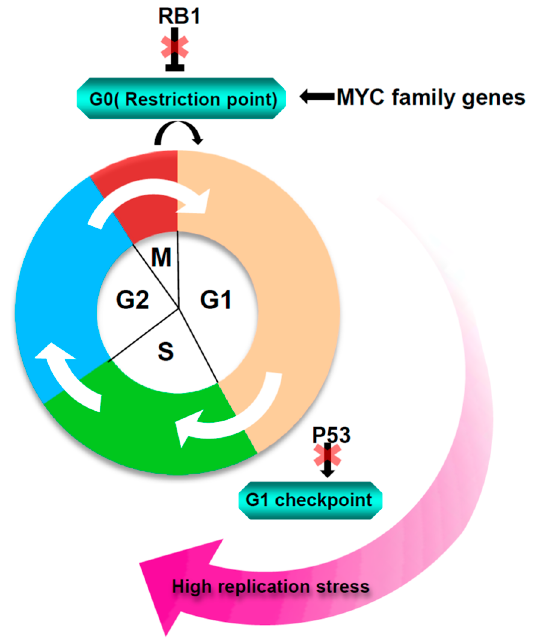
Figure 1. Causes of replication stress in small cell lung cancer (SCLC) cells. A number of endogenous obstacles that lead to replication stress in SCLC, including inactivation of tumor suppressors RB1 and p53, as well as amplification of MYC family genes. RB1 loss or amplification of MYC family genes promotes G0-G1 cell cycle entry, p53 mutation leads to deficient G1 / S DNA damage checkpoint.